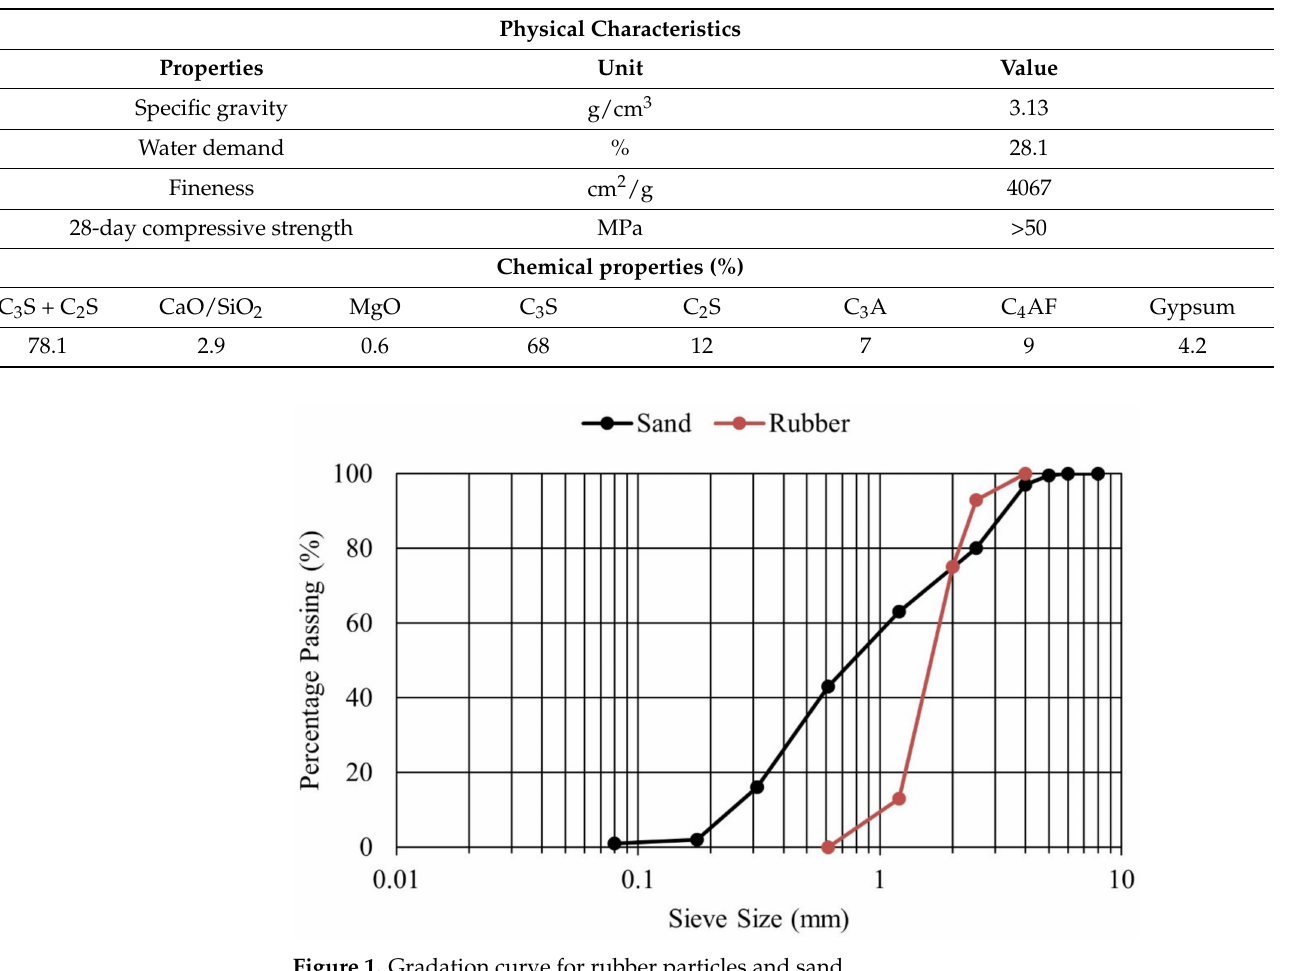
Figure 1. Gradation curve for rubber particles and sand.